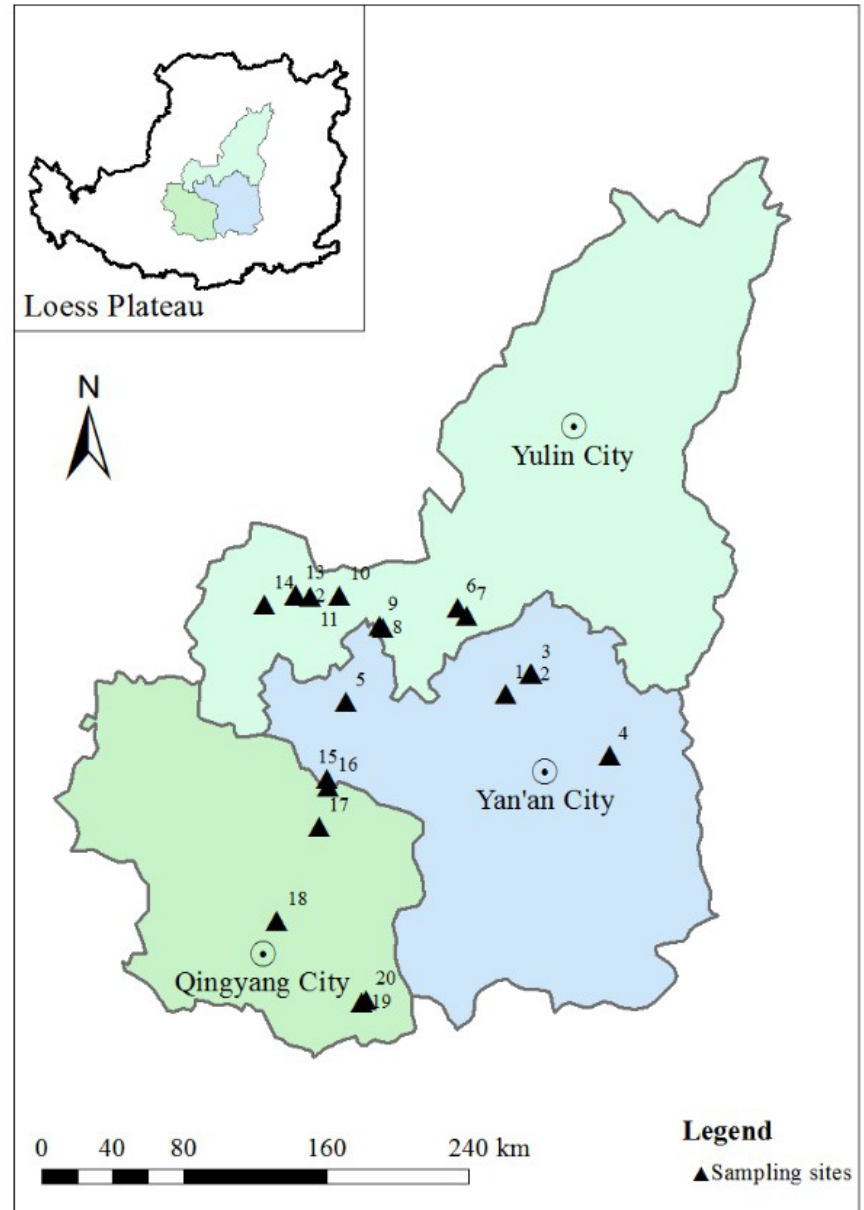
Figure 1. Location of the sampling sites on the Loess Plateau.